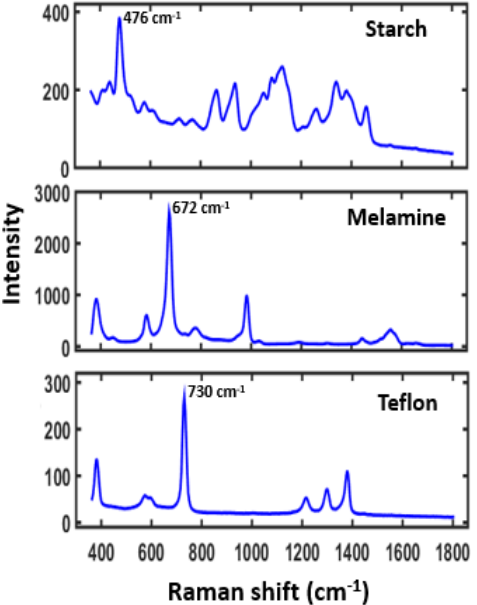
Figure 2. Raman spectra of starch, melamine, and Teflon used in this study to form subsurface and surface layers.